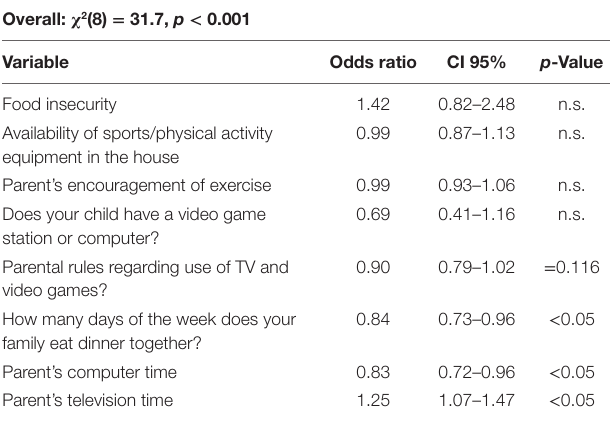
TaBle 4 | logistic regression by obesity ( n = 469). Overall: χ 2 (8) = 31.7, p <